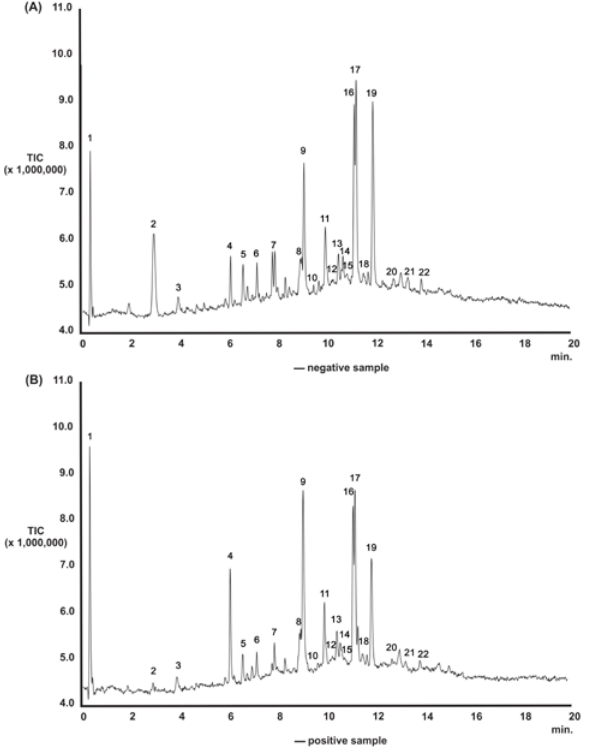
Figure 3. Representative chromatogram of phenolic com- pounds in Xylella fastidiosa subsp. pauca ( Xfp )-positive or negative olive trees (cultivar Ogliarola di Lecce). Amounts of phenolic compounds in leaves of (A) Xfp -negative or (B) Xfp -positive plants. Characterization of peaks is detailed in Table